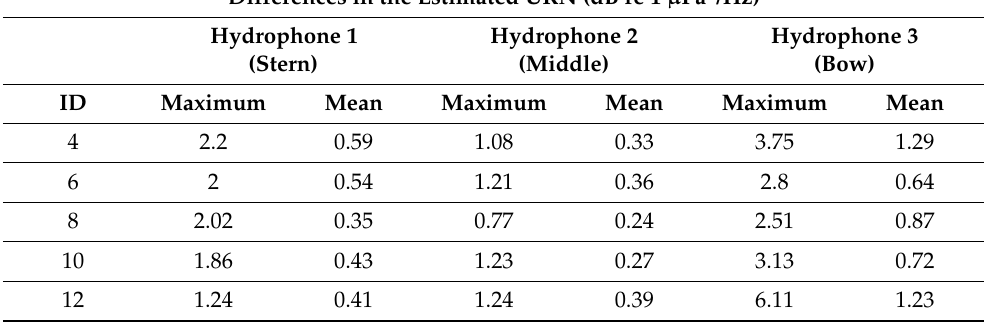
Table 3. Maximum and mean differences between the estimated and measured URN by each hydrophone for all the measurements. ID is the identification number of each